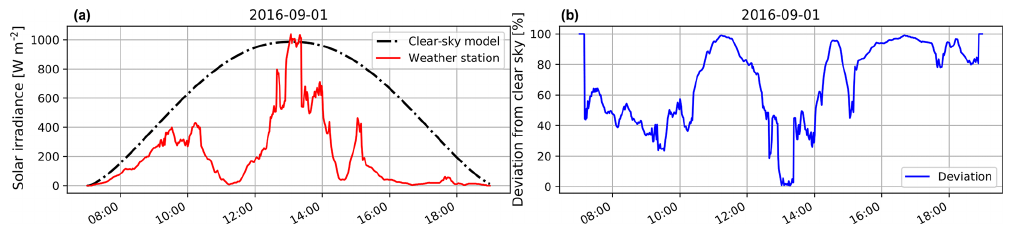
Figure 5. Solar irradiance measurements on 1 September 2016. We plot the (a) measured solar irradiance along with the clear-sky model and the (b) percentage of deviation of solar irradiance from the clear-sky data. Note the rapid fluctuations of high magnitude in the